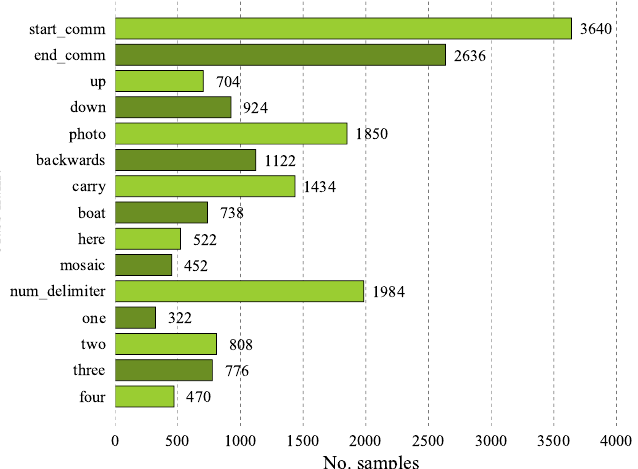
Figure 8. Distribution of gesture classes.